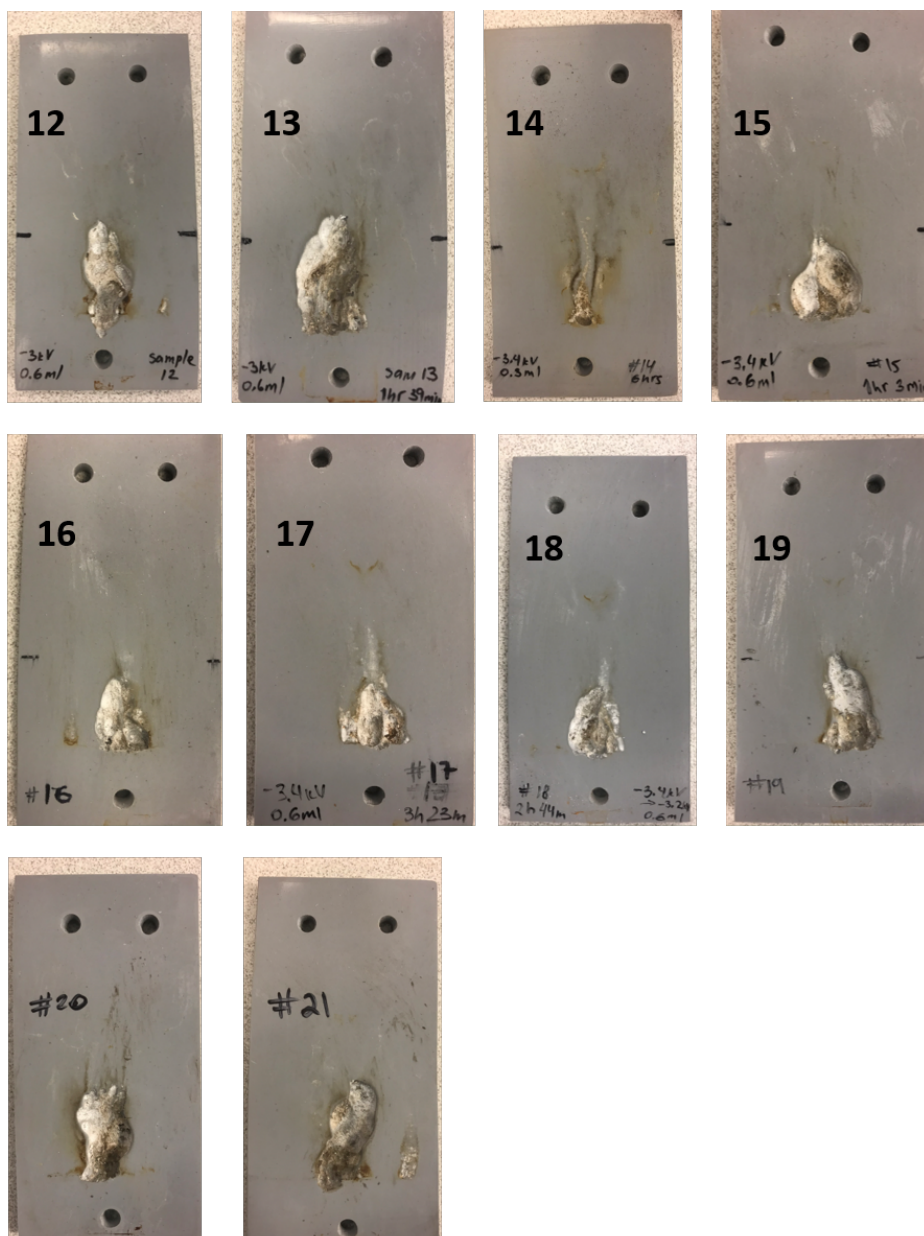
Figure A2. Photographs of test specimens #12–#21 at the end of − DC